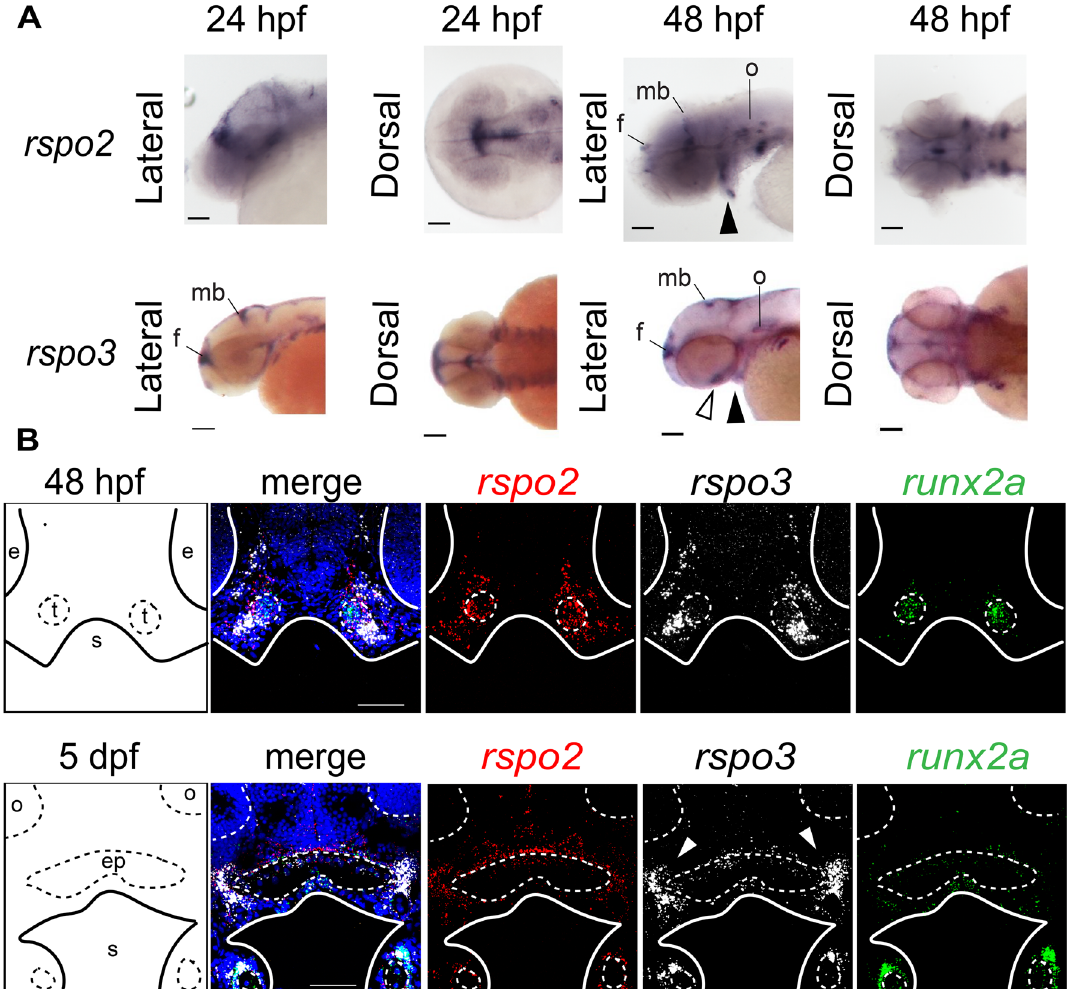
Figure 1. High resolution gene expression analysis detected dynamic spatiotemporal localization of rspo2 and rspo3 transcripts in zebrafish cranial mesenchyme. ( A ) Whole-mount RNA in situ hybridization detected rspo2 and rspo3 transcripts in the midbrain (mb), forebrain (f), otic vesicle (o), and Meckel’s cartilage (arrowhead) at 24 and 48 hpf in lateral and dorsal views. Transcript of rspo3 was additionally detected at 24 and 48 hpf in the forebrain (f) and at 48 hpf in the ethmoid plate (open arrowhead). Scale bar: 100 um. ( B ) Maximum projections of z-stacks of coronal sections of zebrafish embryos, section in plane with eyes. Labeled schematic at left. At 48 hpf, rspo2 and rspo3 transcripts were highly co-localized in the mesenchyme surrounding the condensing trabeculae cartilage mesenchyme, marked by runx2a expression. rspo2 is also detected within the condensing mesenchyme at this timepoint. At 5 dpf rspo2 and rspo3 continue to be co-expressed in mesenchyme and perichondrium surrounding cartilage elements, specifically the ethmoid plate and Meckel’s cartilage. Rspo3 expression is particularly high in runx2a expressing osteogenic precursor cells associated with Meckel’s cartilage, as well as where the palatoquadrate meets the ethmoid plate (white arrowhead). Abbreviations: e: eye, o: olfactory organ, s: stomodeum, t: trabeculae. Scale bar: 100